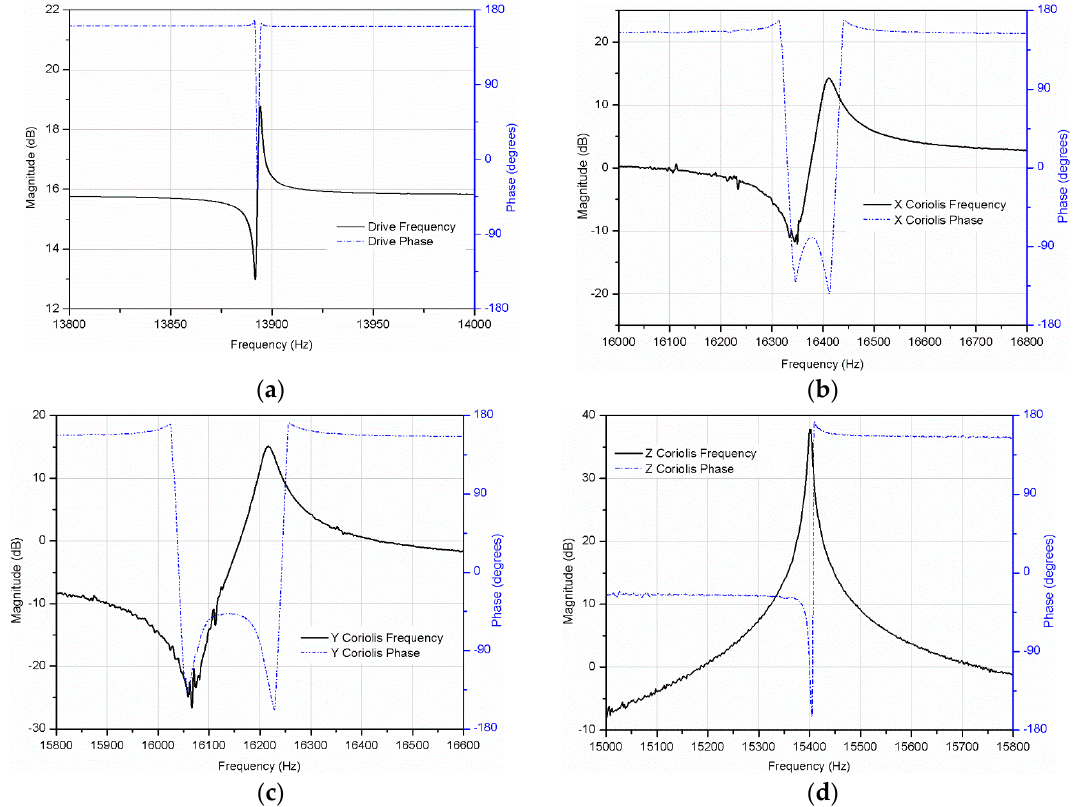
Figure 6. Meaured resonant characteristics of the single drive multi-axis gyroscope ( a ) Drive mode. ( b ) Roll mode. ( c ) Pitch mode. ( d ) Yaw mode.